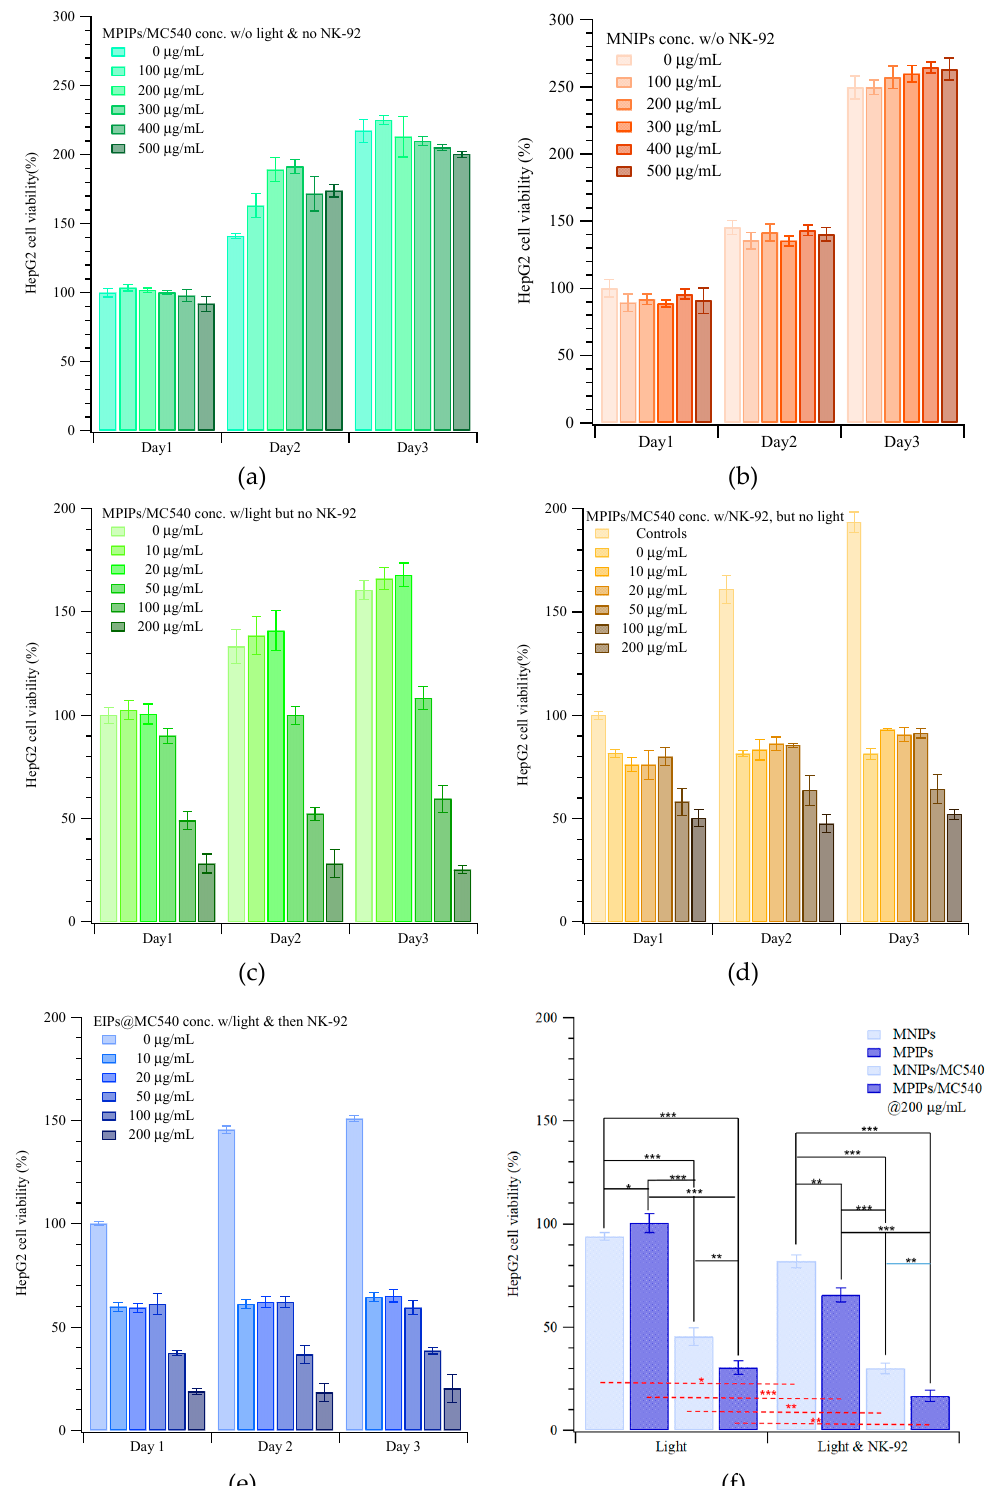
Figure 3. Continuous cellular viability measurements of HepG2 cells incubated with various concentrations of ( a ) MNIPs, ( b ) MPIPs/MC540 without irradiation or NK-92 treatment, ( c ) MPIPs/MC540 with irradiation. ( d ) MPIPs/MC540 with NK-92 treatment, ( e ) MPIPs/MC540 with irradiation or NK-92 treatment, ( f ) Comparison of cellular viability of HepG2 cells with NK-92 cells (2 × 10 4 cells/well), MNIPs/MC540 or MPIPs/MC540 (200 µ g/mL) with or without addition of NK-92 cells (2 × 10 4 cells/well) under irradiation (* p < 0.05; ** p < 0.005; *** p < 0.0005).